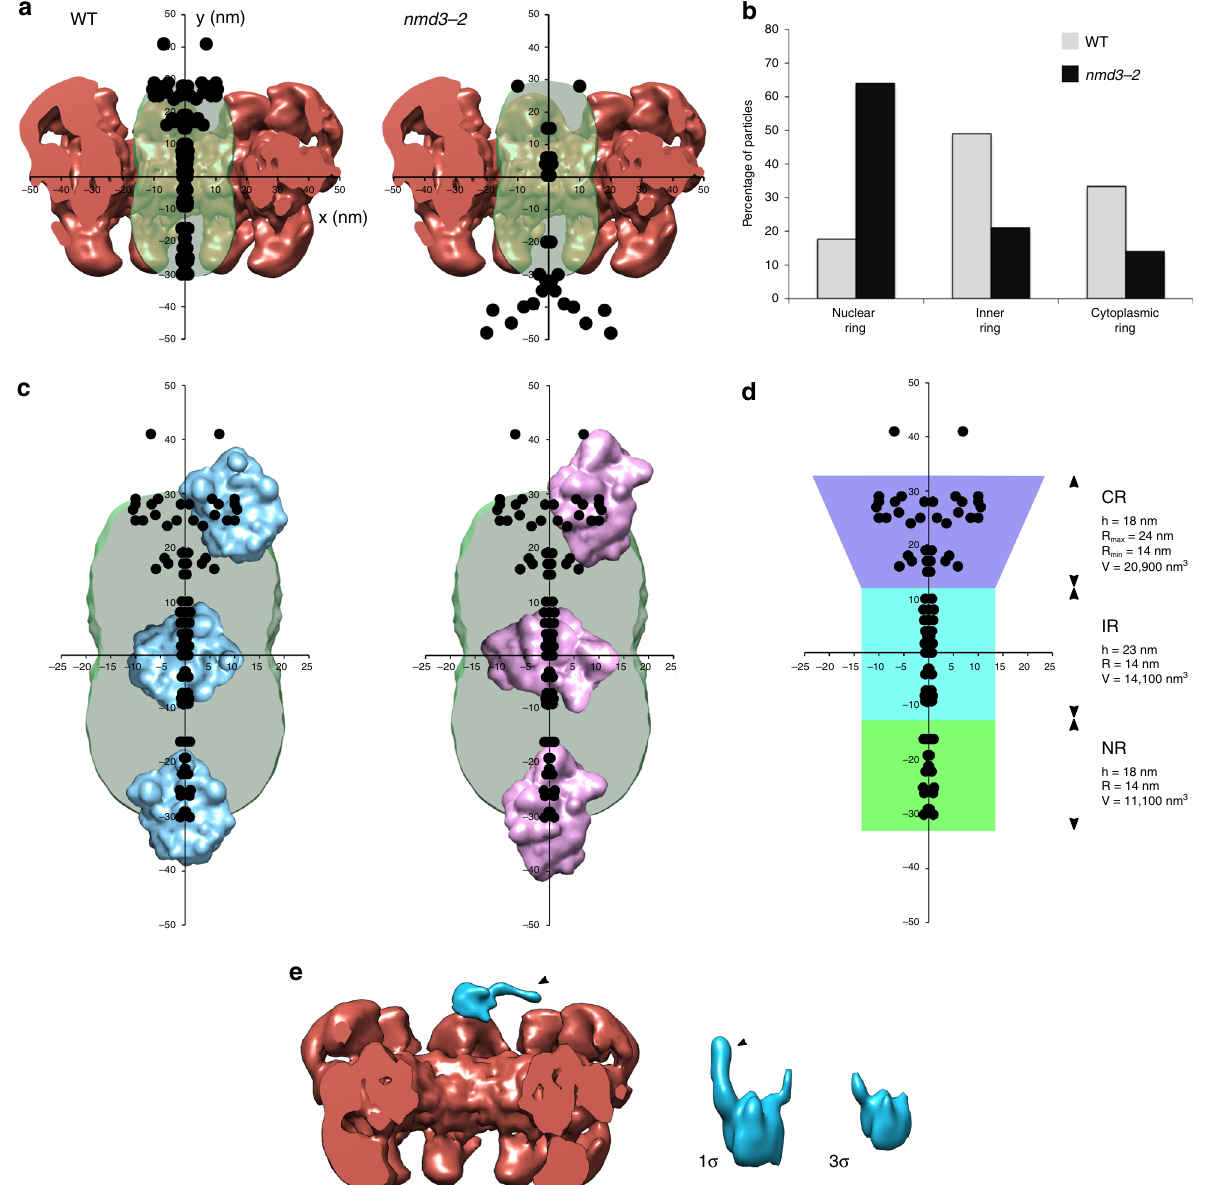
Fig. 4 The path of the pre-ribosomes across the NPC. a Positions of pre-ribosomes in NPCs in wild-type cells (WT) and pre-60S particle nuclear export- defective mutant nmd3-2 . The dots represent the centroid of the particles relative to the median plane section ( X ) and the central axis ( Y ) of the NPC. The distribution was mirrored along the Y -axis for the representation. b Distribution of pre-ribosomal particles in the nuclear, inner, and cytoplasmic rings in wild-type and nmd3-2 cells. c The central transporter was superimposed with the distribution of pre-ribosomal particles as in a and with pre-60S (blue) or a pre-40S (pink) particles at the same scale. The central transporter is large enough to accommodate pre-ribosomes whatever their orientation. The path of the particles is constrained in a 25 – 30 nm diameter channel at the center of the nuclear and inner rings. d The volume of the space explored by pre- ribosomal particles was estimated in the nuclear, inner, and cytoplasmic rings the NPC. For the diameter of the central channel, we took into consideration the longest dimension of a pre-ribosomal particle, i.e. 28 nm for a pre-40S particle 65 . e A representative 3D reconstruction of a pre-ribosome at the cytoplasmic ring showing additional densities pointing towards the NPC, almost perpendicular to the central axis (black arrow). On this example, segmentation was performed by isosurfacing with a gray-level cut-off of 1 σ but the additional density is still detected with 3 σ cut-off ( σ : standard deviation of the gray-level distribution). Source data for a and b are provided as a Source Data fi